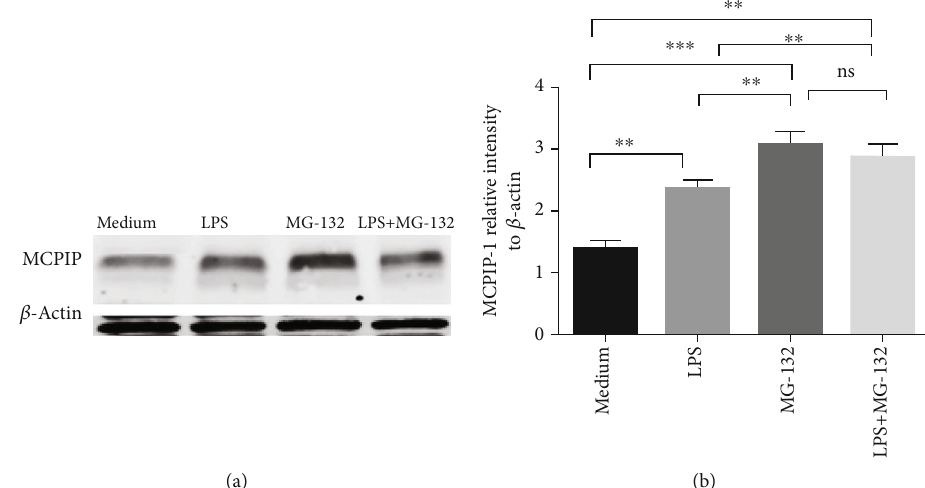
Figure 2: MG-132 facilitates expression of MCPIP-1 in neutrophils. Peripheral neutrophils ( 1 × 10 6 ) were isolated from HC ( n = 8 ) and stimulated in vitro in the absence (medium alone) or presence of LPS (100ng/mL), MG-132 (20 μ M), and LPS (100ng/mL) together with MG-132 (20 μ M) for 3 hours. Protein was extracted from these cells, and expression of MCPIP was determined by Western blotting (a) and quanti fi ed in gray value (b). ∗ P < 0 : 05 and ∗∗ P < 0 : 01 . Abbreviation: ns, not signi fi cant.